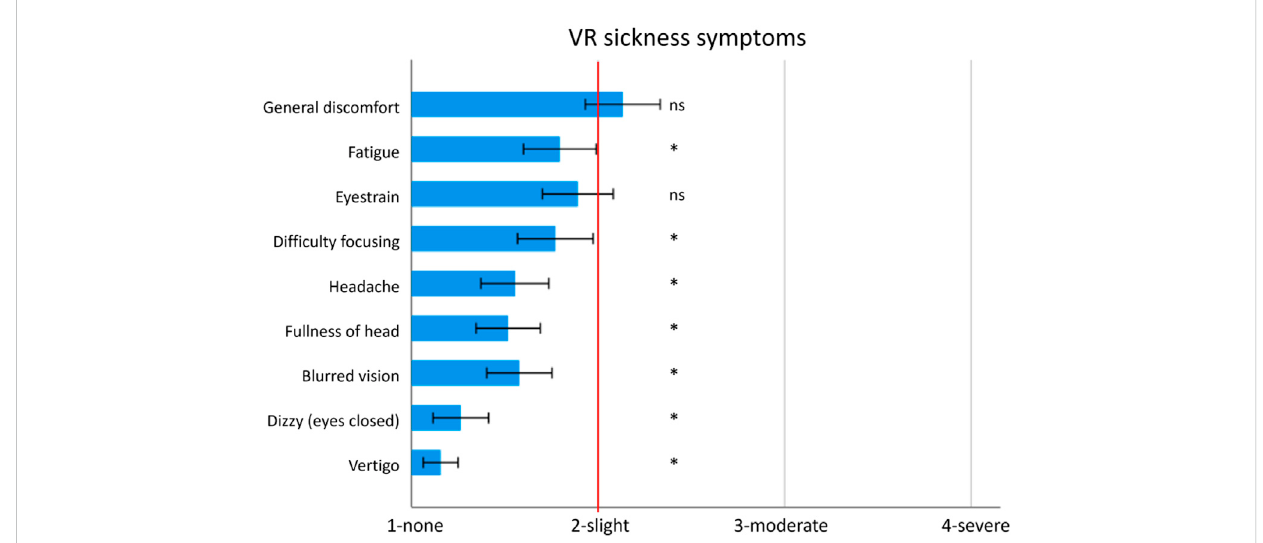
FIGURE 3 Mean valuesof VR-sickness symptoms and results from t-tests against scale level 2 = “ slightsymptom ” (* = signi fi cant difference from “ 2 ” ; n. s= not signi fi cant).